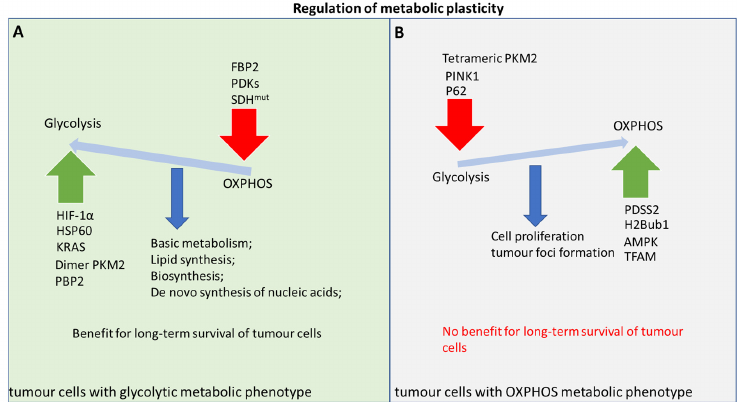
Figure 3. Partial metabolic plasticity regulation in tumour cells. Many molecules can cause tumour cells to switch between glycolysis and OXPHOS phenotype. ( A ) For tumour cells with glycolysis metabolic phenotype, many factors can directly or indirectly regulate the glycolysis process, such as HIF-1 α , which can regulate HK-2, PDK1, GLUT1; HSP60, which can strengthen glycolysis reaction, reduce OXPHOS, and reduce the transition from glycolysis to OXPHOS; KRAS, which can regulate the critical enzymes of HK, PFK1, LDHA, and GLUT1, thus affecting the glycolysis process; inactivated PKM2 (Dimer PKM2), which manifest that metabolites accumulate in tumour cells mainly by glycolysis; and FBP2, which can bind to and activate PKM2, making cells for executing glycolysis reactions. In addition, by affecting the mitochondria-related molecules, which can also shift the metabolism to glycolysis phenotype, such as FBP2, it can present the inhibitory effect on mitochondrial transcription factor NRFs and TFAM. Some PDK isoforms can restrict pyruvate entry into mitochondria, and the mutation of SDH can promote the expression of multiple glycolytic enzyme genes. High glycolysis flux levels can help basic metabolism, lipid metabolism, biosynthesis, and denovo synthesis of nucleic acid. In addition, glycolysis flux does not produce oxidative stress molecules to harm tumour cells. Therefore, the glycolysis metabolic phenotype is beneficial for the long-term survival of tumour cells. ( B ) Tumour cells with OXPHOS metabolic phenotype also have many factors that can directly or indirectly regulate the OXPHOS process. For example, activating PKM2 (Tetrameric PKM2) can catalyze phosphoenolpyruvate (PEP) to pyruvate and promote its entry into the TCA cycle. An overexpression of PTEN-induced kinase 1 (PINK1) can promote mitophagy, reduce glycolysis, and increase OXPHOS. Autophagy protein P62 can recognize polyubiquitination of HK-2, catalysed by E3 ligase TRAF6, and then initiate the degradation of HK-2, thereby inhibiting the glycolysis levels. In addition, some effector molecules can directly promote OXPHOS, such as by directly regulating PDSS2, increasing the activity of CoQ10 and mitochondrial Complex I. H2Bub1 regulates a series of mitochondrial genes that can be used for OXPHOS and inhibit the glycolysis level. AMPK is a core molecule regulating mitochondrial energy metabolism, which can enhance mitochondrial metabolism in multiple ways. TFAM plays a critical role in mitochondrial activity and gene transcription. High levels of OXPHOS can help with proliferation and tumour foci formation. However, OXPHOS is not good for the long-term survival of tumour cells because excessive OXPHOS may lead to more oxidative stress molecules that can damage tumour cells and cause the death of tumour cells. In addition, the stability of genes, such as tumour protein p53 (TP53), KRAS, kelch-like ECH-associated protein 1 (Keap1), serine/threonine kinase 11 (STK11), EGFR, neurofi- bromin 1 (NF1), and B-Raf proto-oncogene, serine/threonine kinase (BRAF) is related to metabolic changes [314–316], the most important of which is the effect of the p53 gene on metabolism. At present, the effects of P53 on metabolic remodeling have been studied in many aspects, such as TP53-induced glycolysis regulatory phosphatase (TIGAR), glycolysis, and glucose transporter; the synthesis of cytochrome c oxidase 2 (SCO2) and